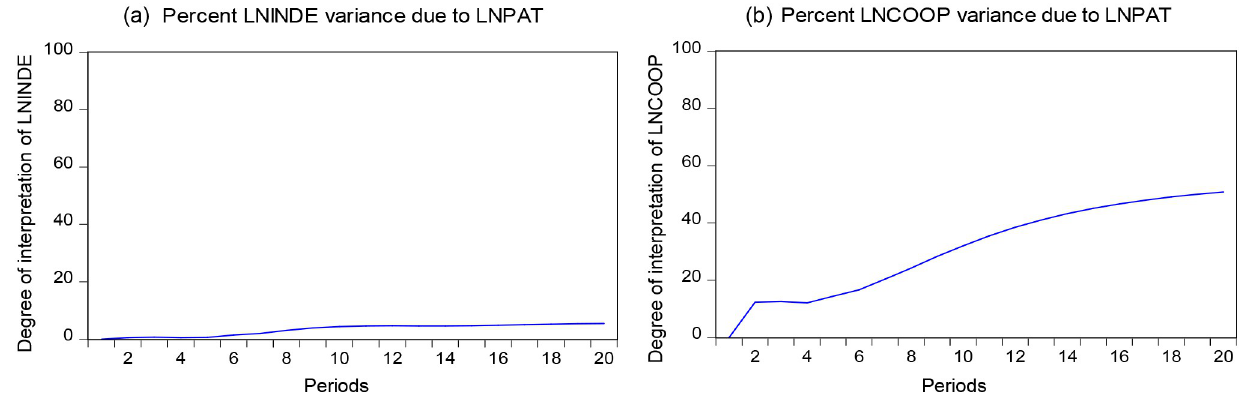
Fig 5. Variance decompositions results of LNPAT on LNINDE, LNCOOP.